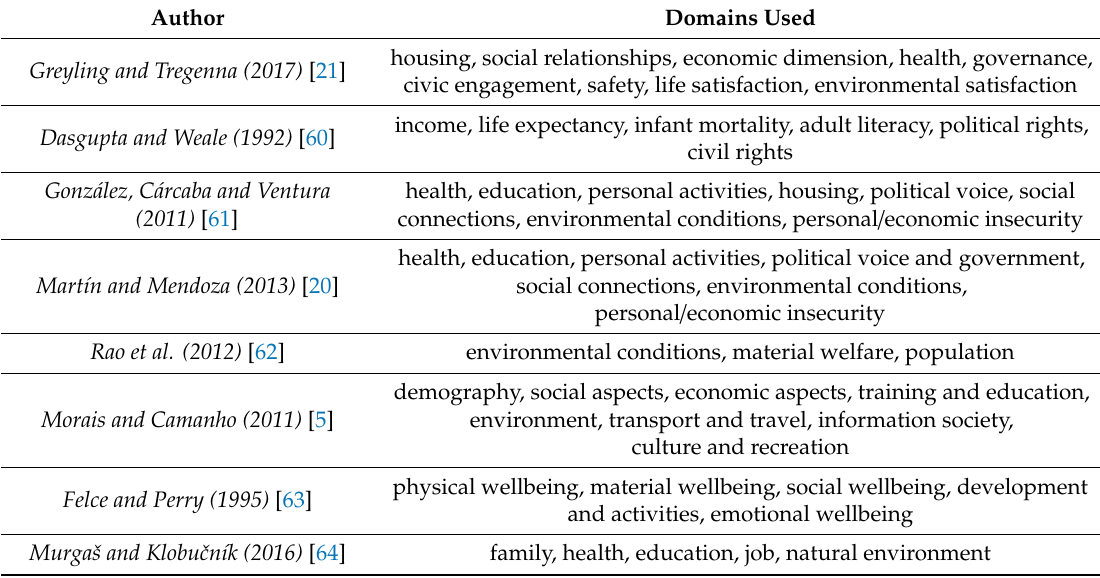
Table A2. A list of studies from the literature review and their domains of quality of